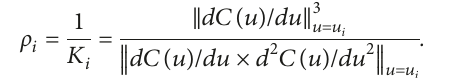
Figure 4: Geometric relationship of error